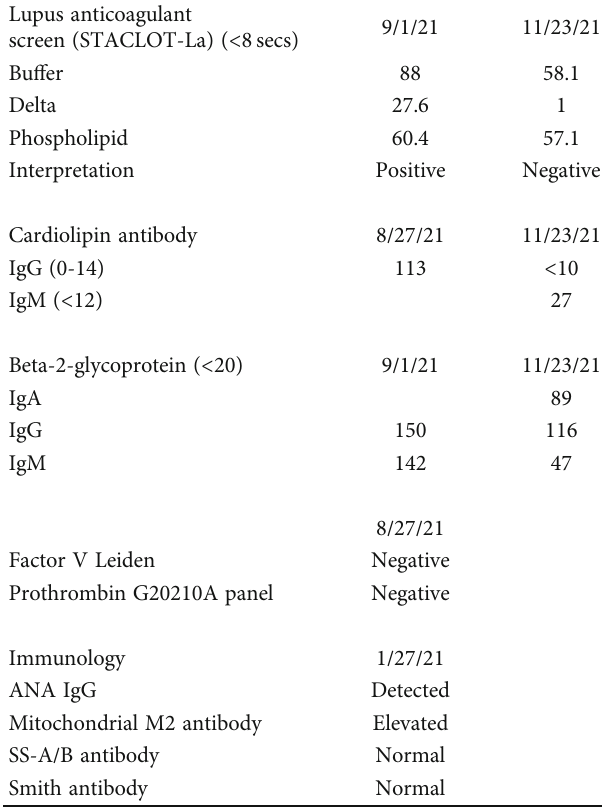
Table 1: Results of hematologic